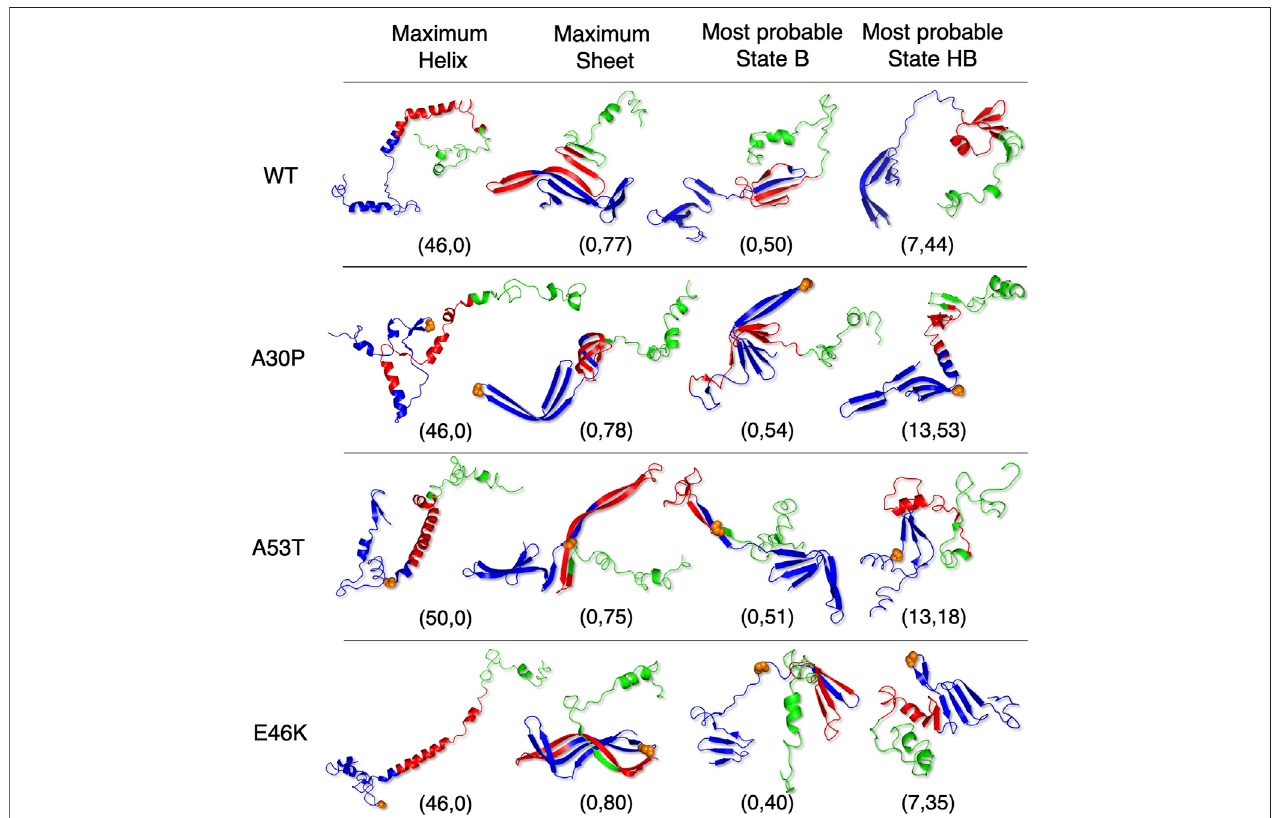
FIGURE 6 | Selected representative structures for WT and mutants extracted from the conformational sub-ensembles corresponding to the maximum fraction in the helix ( fi rst column), the maximum fraction in the β -sheet (second column), the most probable sub-state of state B (third column), and the most probable sub-state of state HB (last column). The coordinates correspond to the position in ( α , β ) maps of Figure 4 . Orange spheres represent backbone atoms at the mutation location. The 3D representations were made with the PyMOL software (Schrödinger,